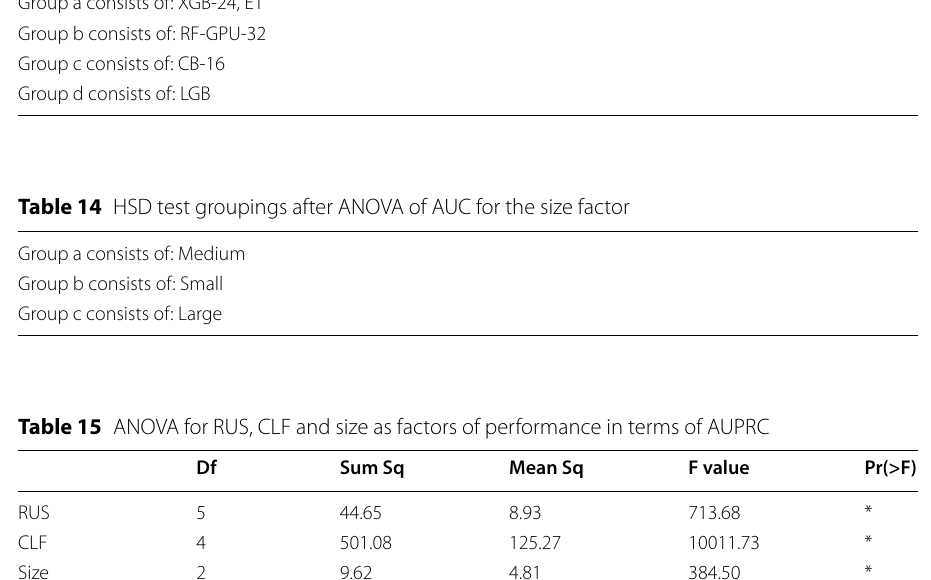
Table 13 HSD test groupings after ANOVA of AUC for the CLF factor Group a consists of: XGB-24, ET Group b consists of: RF-GPU-32 Group c consists of: CB-16 Group d consists of: LGB